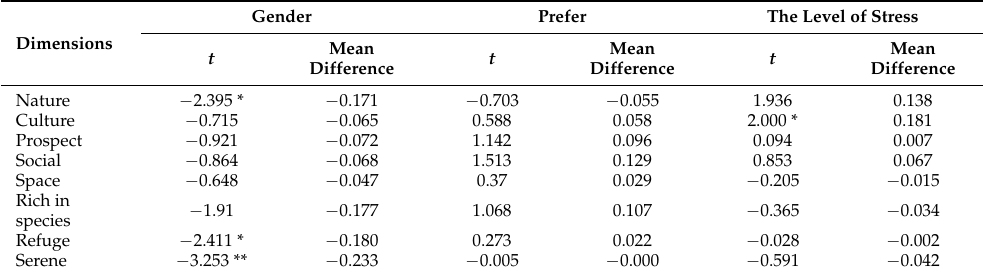
Table 6. The results of independent sample t -test results with gender, Prefer and LS as grouped variables and the eight PSDs as test variables.